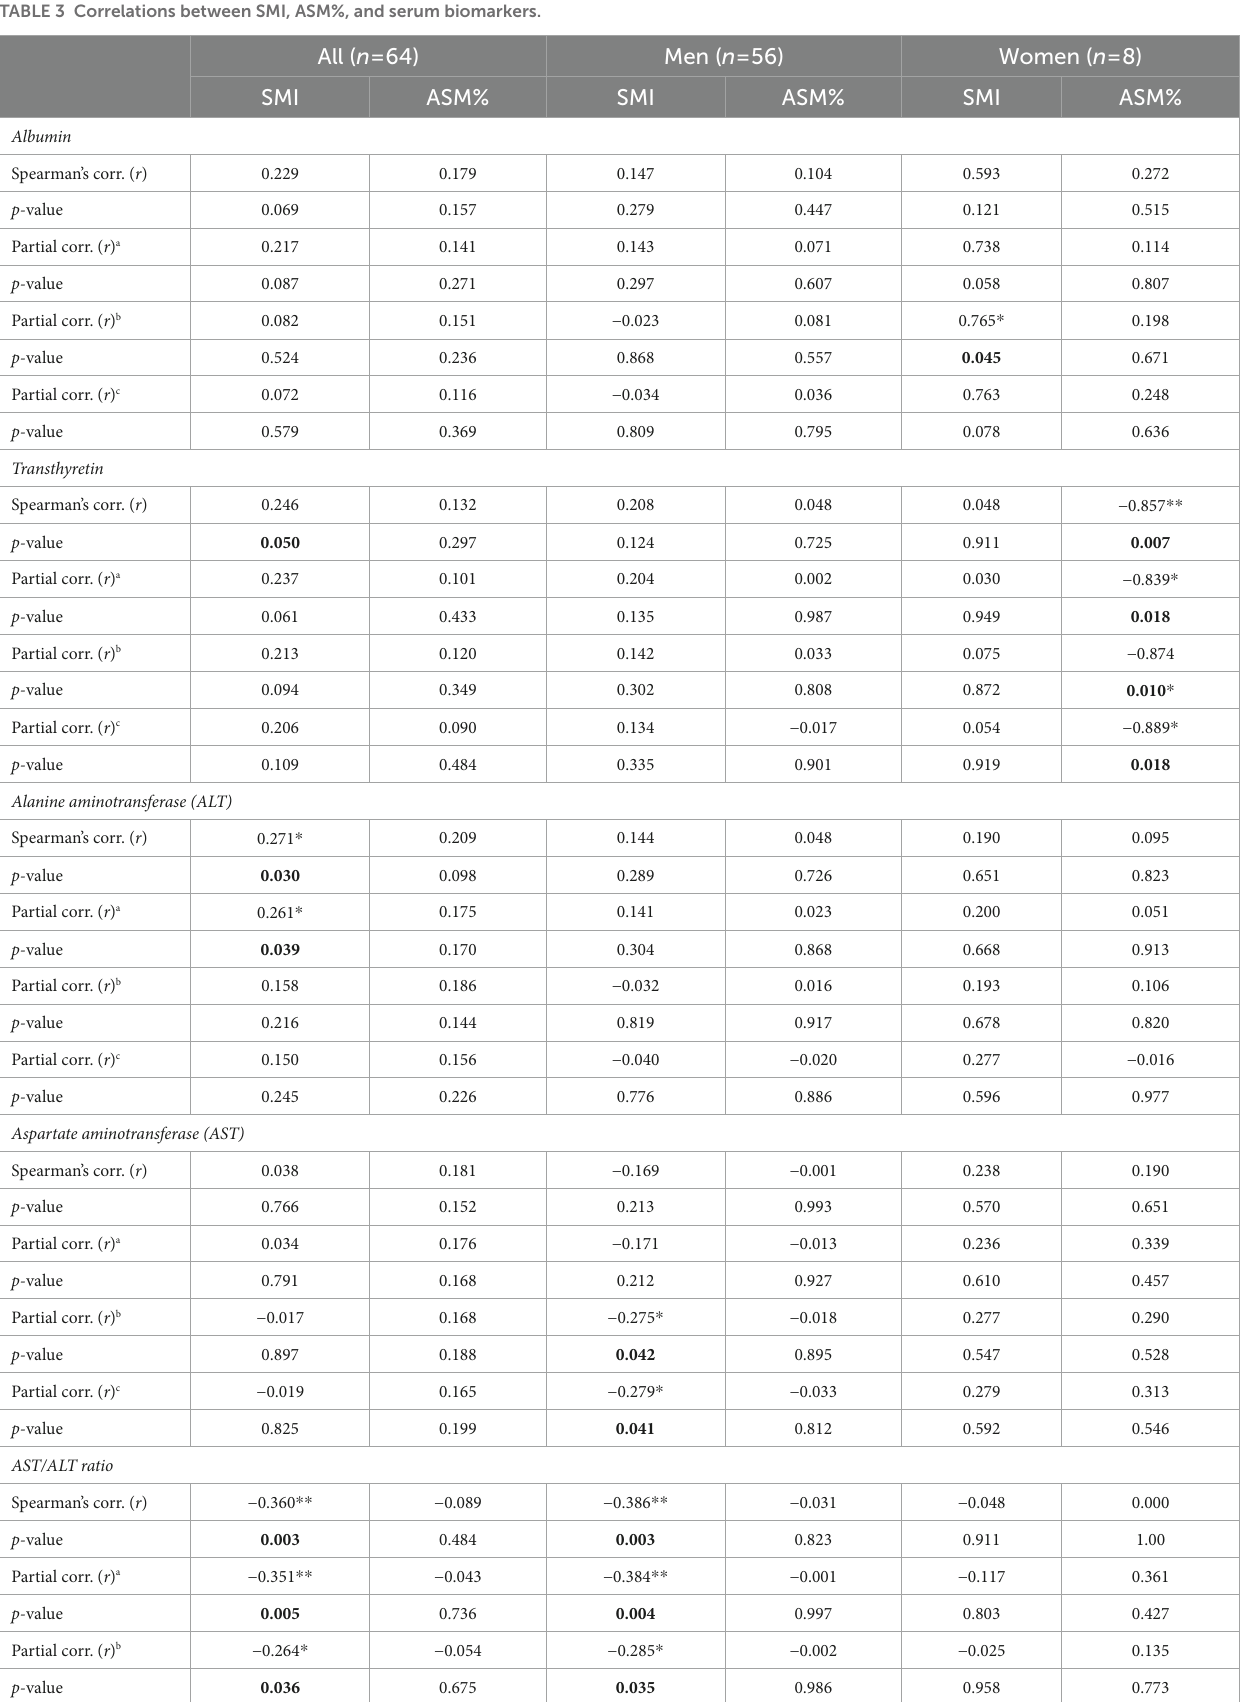
TABLE 3 Correlations between SMI, ASM%, and serum biomarkers. All ( n = 64) Men ( n = 56) Women ( n = 8) SMI ASM% SMI ASM% SMI